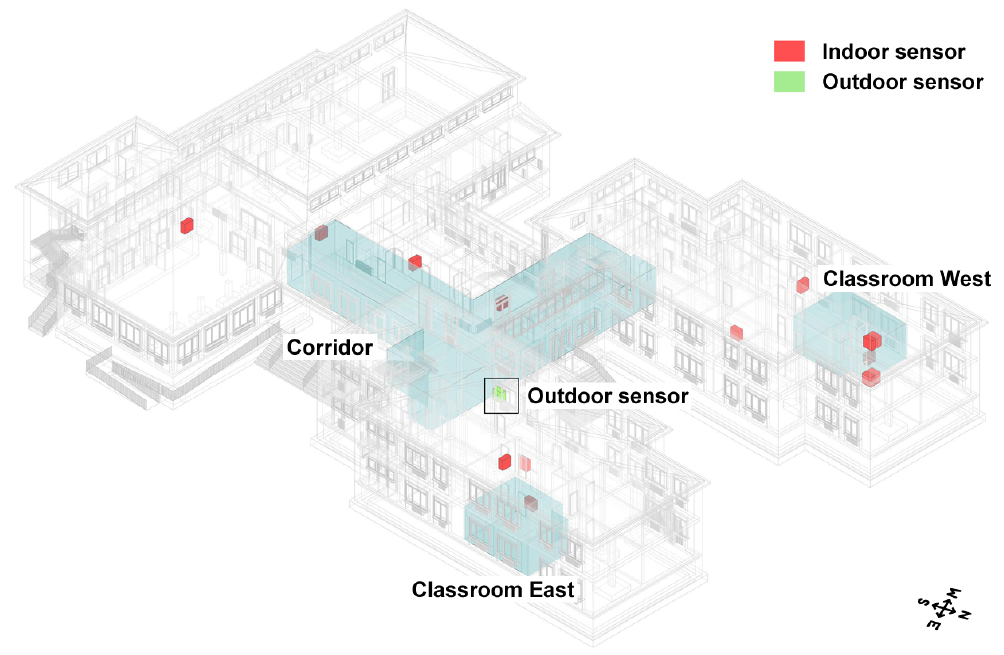
Figure 1. BIM model of the case-study building (reference rooms are highlighted in